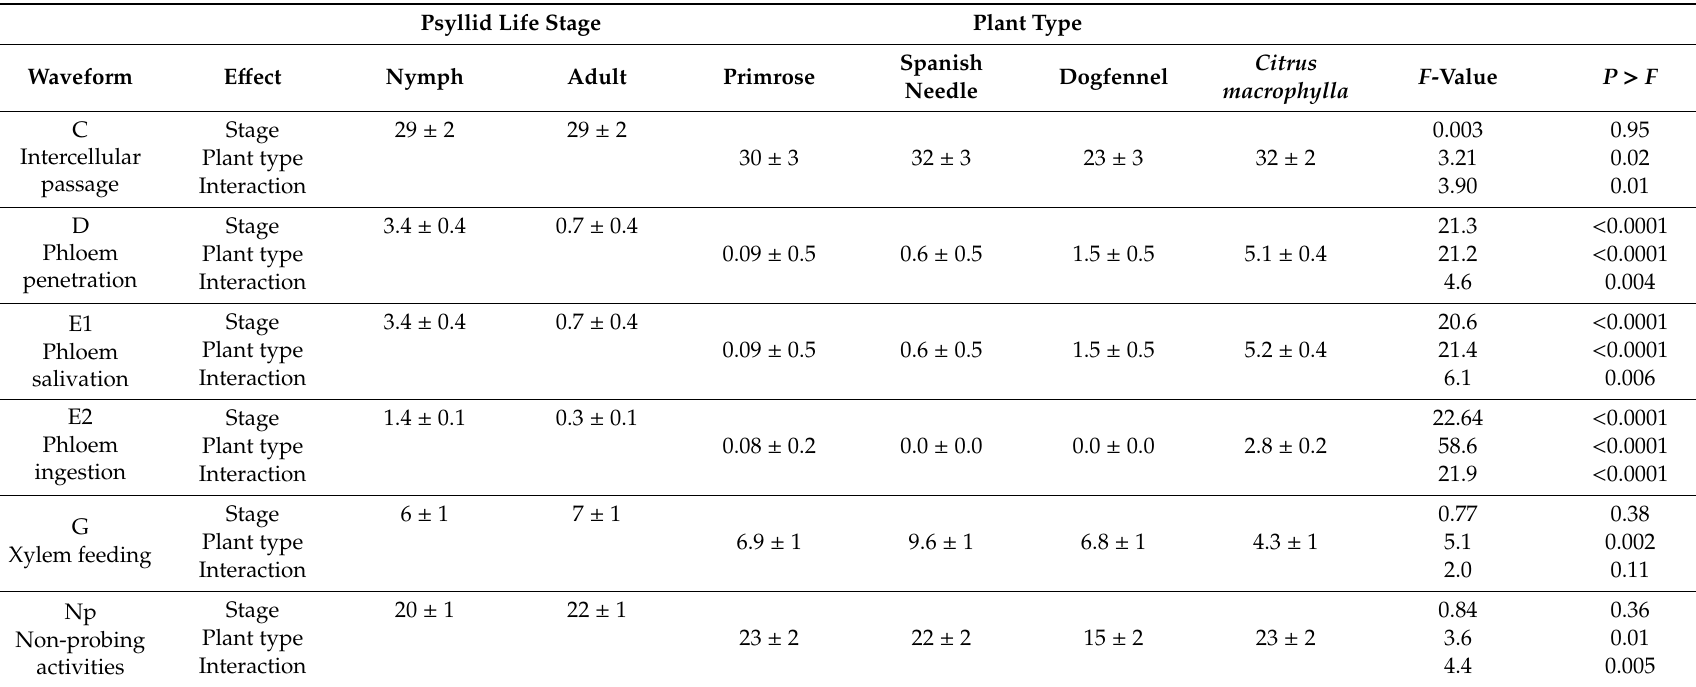
Table 1. Mean ( ± SEM) frequency (no. of bouts) of feeding activities by Diaphorina citri adults and nymphs on weed species and C . macrophylla during 18 h